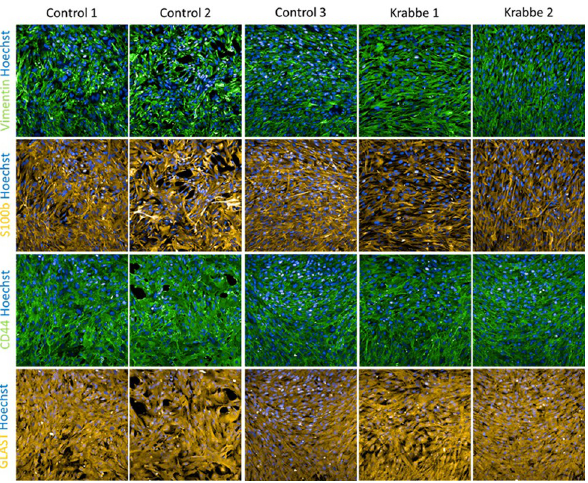
Fig 1. Assessment of differentiation into astrocyte lineage. Representative images of astrocytes differentiated from 3 healthy control donors and 2 donors with infantile onset Krabbe disease caused by a large deletion in the GALC gene. Cryopreserved astrocytes were thawed and cultured for 7 days prior to fixation and imaging. Immunocytochemistry revealed positive staining for astrocyte markers vimentin, s100 β , CD44, and GLAST (EAAT1) in all cell lines used. Images were taken at 20x